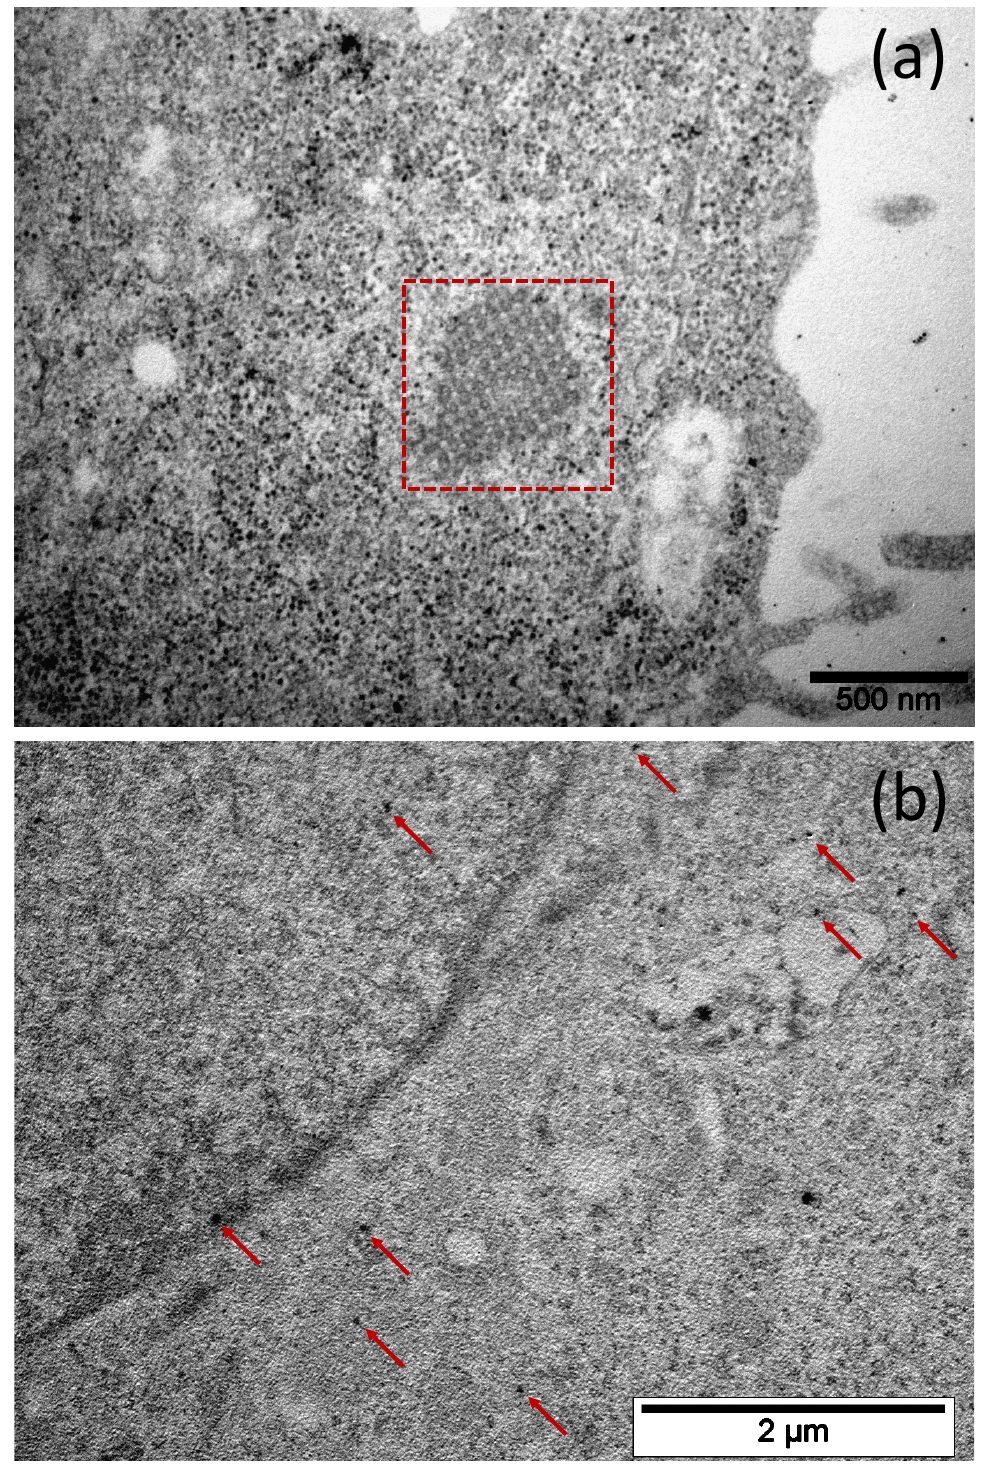
Figure 6. Bright-field TEM image of an ultrathin section of a 4T1-Qt cell, aggregated encapsulin shells in the cytoplasm are highlighted by a square ( a ), and red arrows indicate electron-dense nanoparticles in 4T1-Qt cell cytoplasm cell, scale bar 500 nm and 2 µm, respectively ( b ).